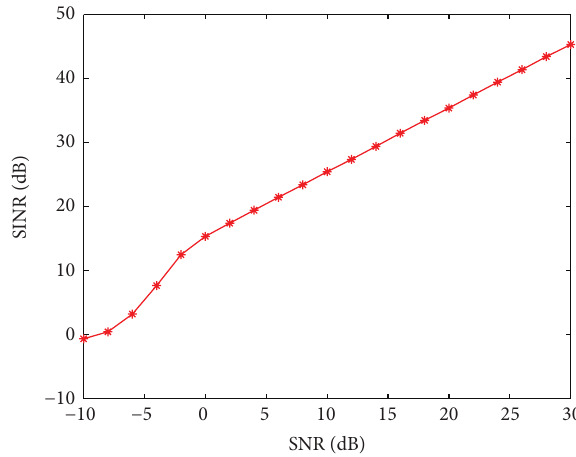
Figure 5: Output SINR versus SNR of iterative LCMV with CS-SL0 reconstructed